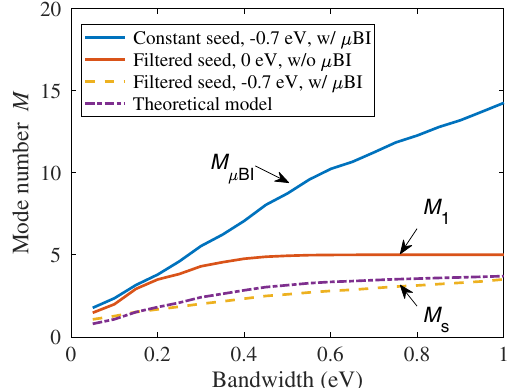
FIG. 7. The effective number of modes M of seed and pedestal as a function of the amplitude of the hypothetical μ BI spectra.